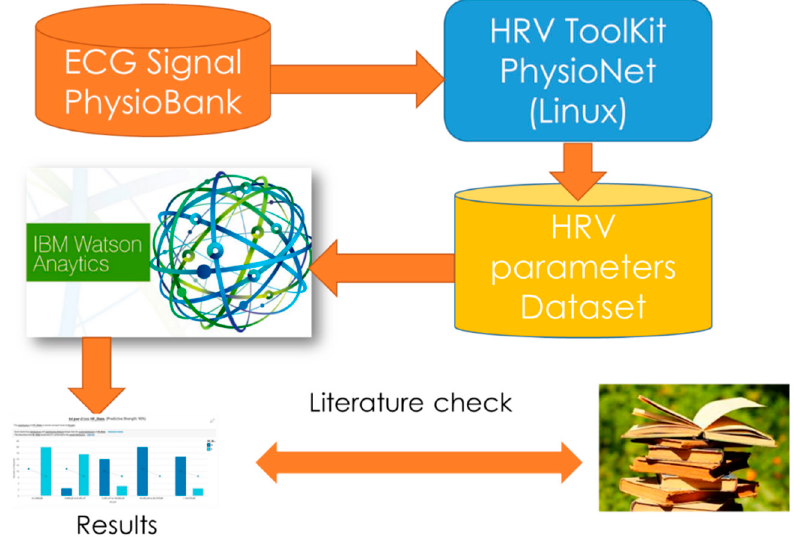
Figure 2. Diagram showing the workflow our study.